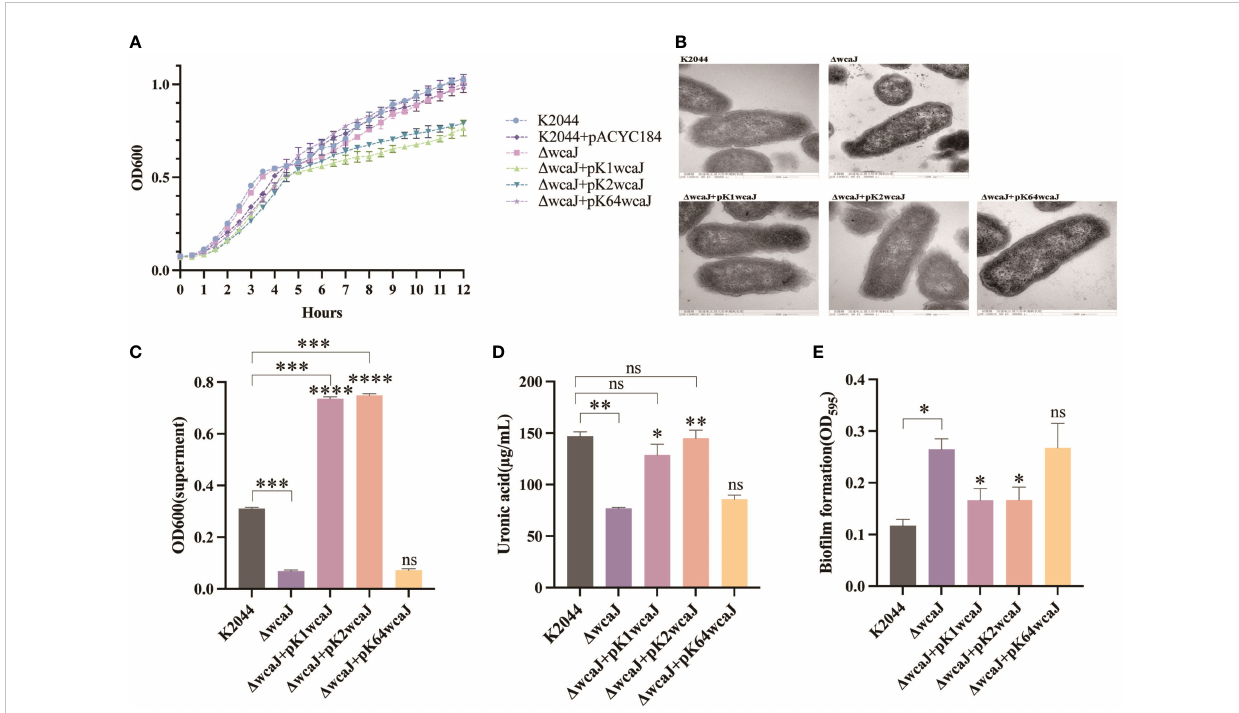
FIGURE 3 Capsule formation in various Klebsiella pneumoniae mutants. (A) The 12 h growth curves of different strains. (B) Transmission electron microscopy images of the capsule. Assessment of (C) the mucoviscosity of the culture supernatants, (D) the production of uronic acid, and (E) the formation of bio fi lm. K2044 D wcaJ was used as a negative control. An unpaired two-sided Student ’ s t-test was used for comparisons between K2044 D wcaJ and its mutants. Each data point represents an average of three independent replicates (n = 3). The values of culture supernatants, uronic acid, and bio fi lm formation were normalized to OD600. Data are presented in the form mean ± SEM. *** P < 0.001, ** P < 0.01, * P < 0.05, ns: not signi fi cant. ****P < 0.0001, ***P < 0.001, **P < 0.01, *P < 0.05, ns, not signi fi